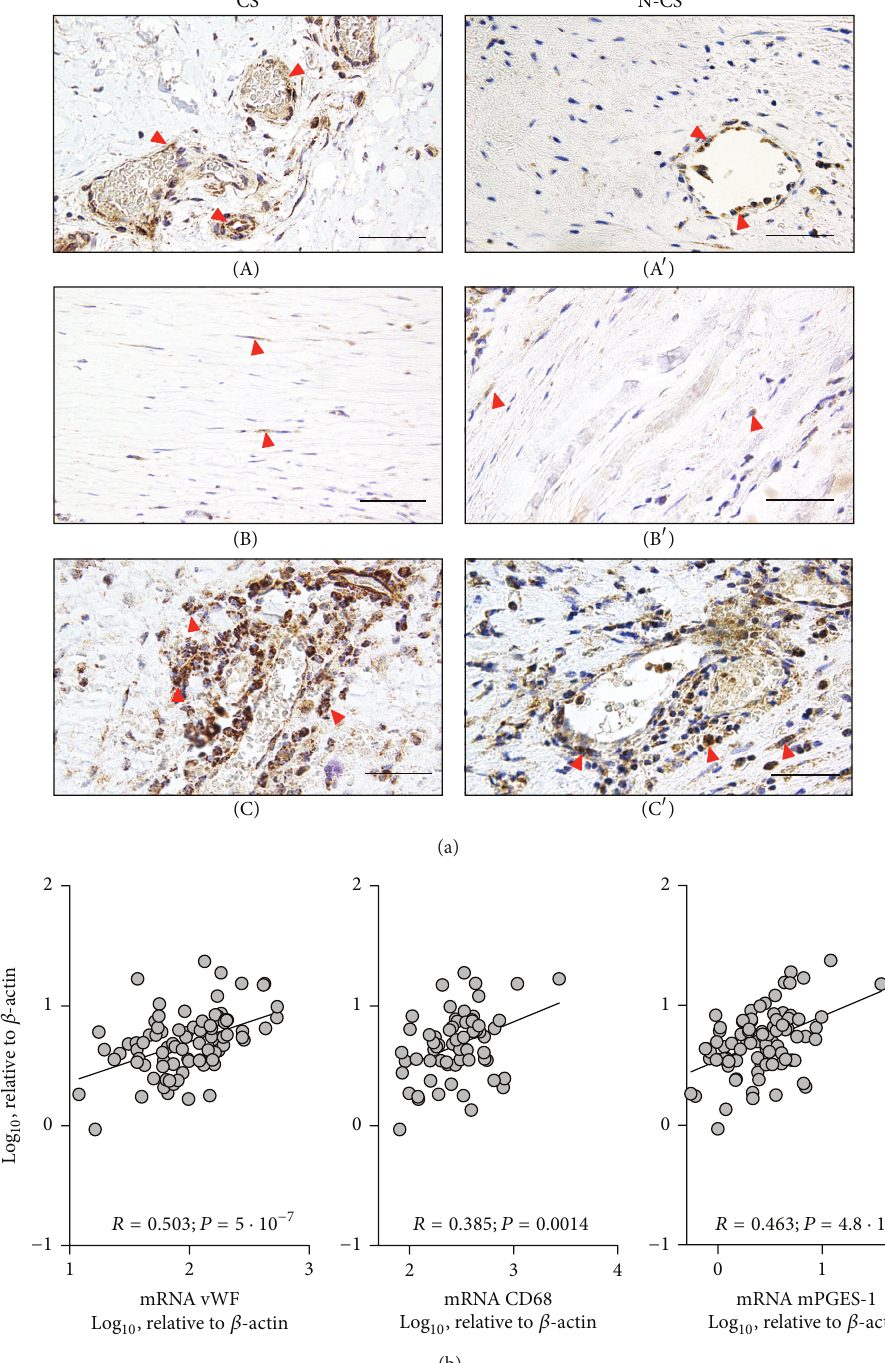
Figure 3: (a) Representative immunohistochemical images of EP-4 in aorta samples from current smokers (CS, left) and noncurrent smokers (N-CS, right) patients, showing EP-4 immunostaining of MVEC (A, A 󸀠 ), the scarce presence of EP-4 immunostaining in media layer in areas free of leucocyte infiltration (B, B 󸀠 ), and EP-4 positive leukocytes (C, C 󸀠 ). Red arrow-ends indicate some immunostained cells. Size bars: 50 𝜇 m. (b) Correlation between mPGES-1 transcript levels and those of endothelial cell and macrophage markers and between EP-4 and mPGES-1; Pearson product moment correlation applied to log 10-transformed data ( 𝑛 = 89